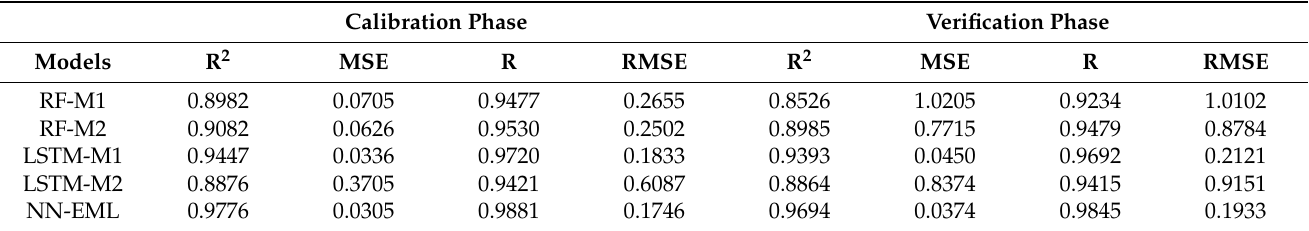
Table 5. Results and performance analysis of the